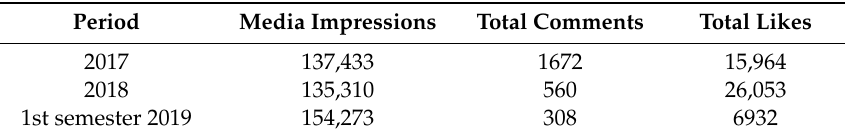
Table 3. CEE impact indicators on Facebook 2017–2018–2019.